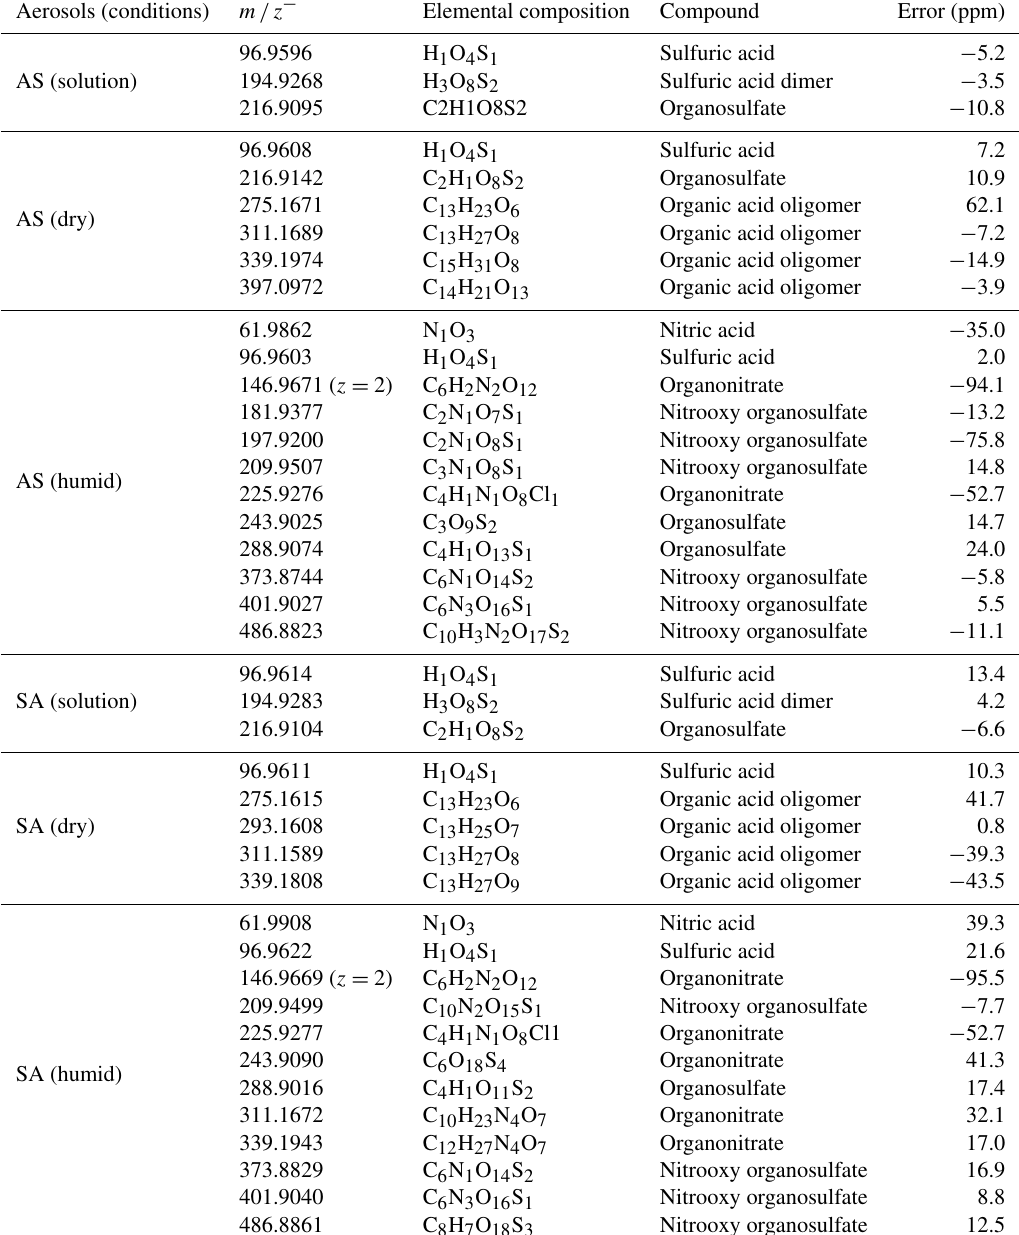
Table 3. Elemental compositions of organic–inorganic compounds in dark reactions (UPLC-HR-Q-TOF-MS negative-mode analysis). Aerosols (conditions) m / z